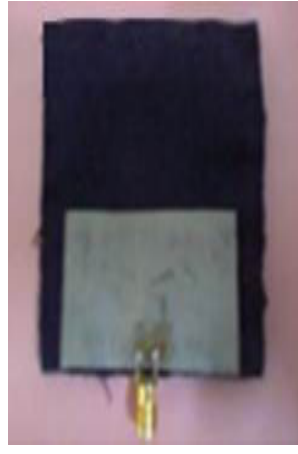
Figure 9: Desired hardware antenna on